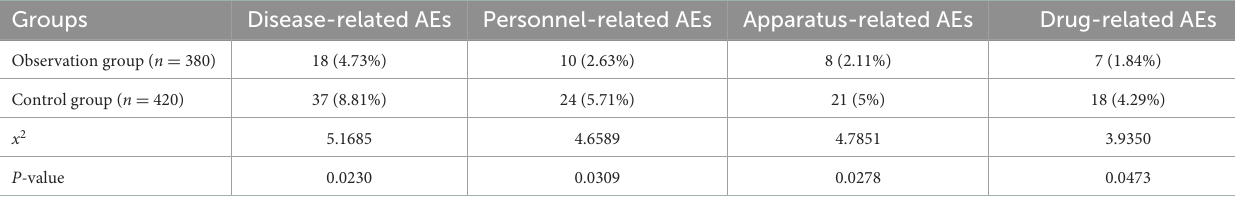
TABLE 4 Incidence of adverse events (AEs) in the observation and control groups.